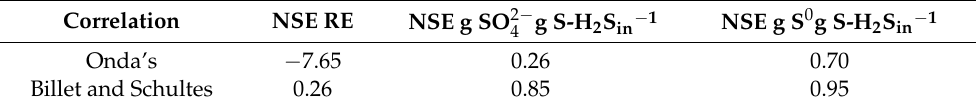
Table 4. Nash-Sutcliffe model efficiency (NSE) for the Onda and Billet and Schultes Correlations. Correlation